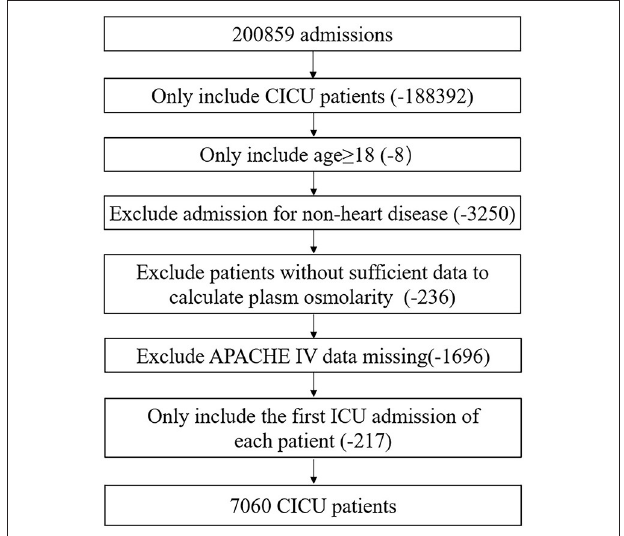
FIGURE 1 | Flow chart of study population. CICU, cardiac intensive care unit; APACHE IV, acute physiology and chronic health evaluation IV.